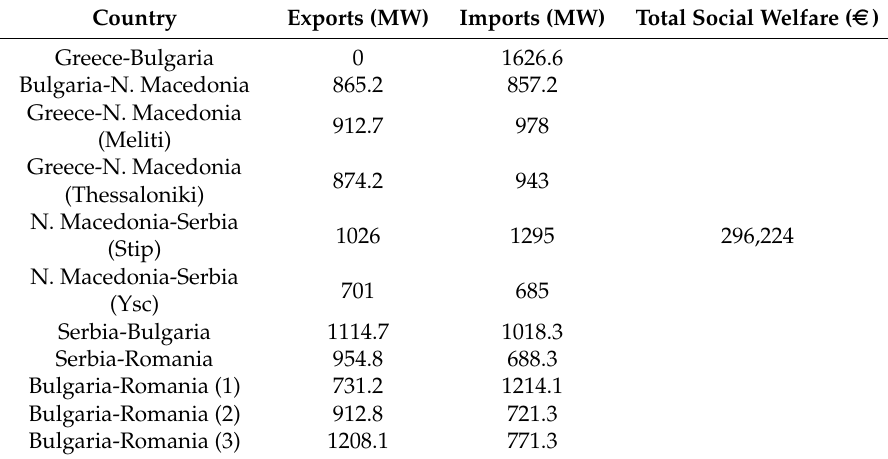
Table 8. Cross-border flows via the FB method for the 5 country scenario.